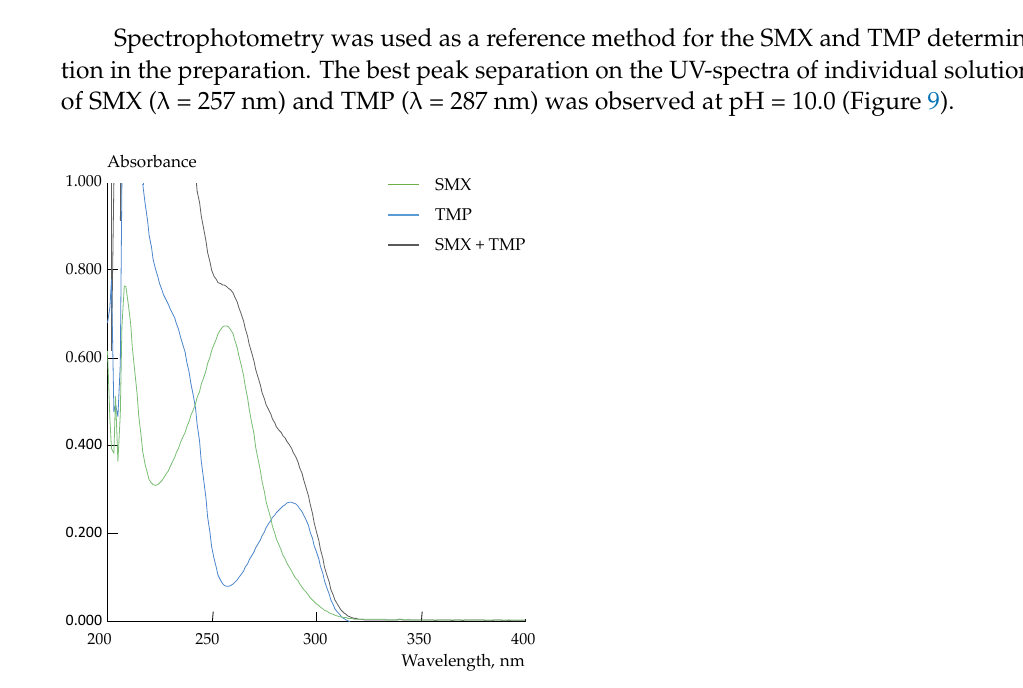
Figure 9. UV-spectra of SMX, TMP, and their equimolar solutions with the concentration of the components of 4.0 × 10 − 5 M at pH 10.0 .